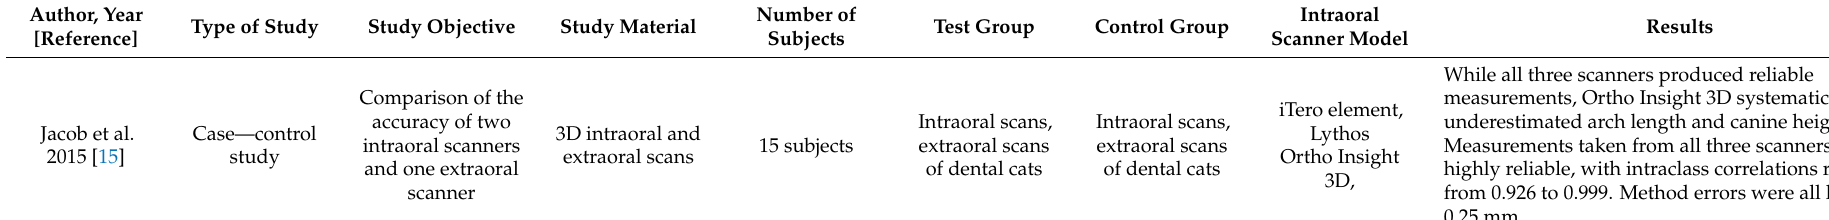
Table 1. Characteristics of the included